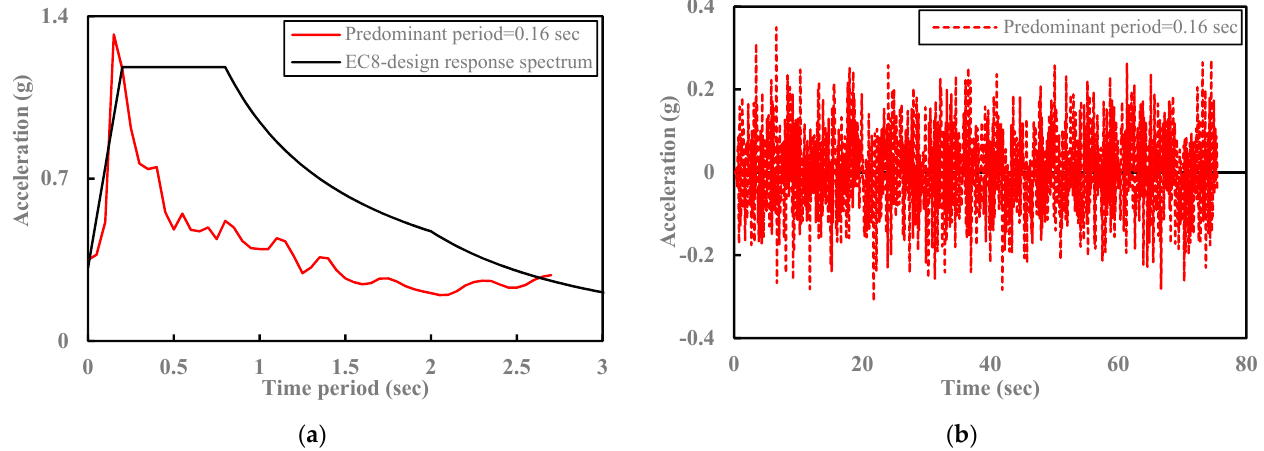
Figure 3. Comparison of the artificial and design earthquake input data including ( a ) the design response spectrum and ( b ) the acceleration time histories.